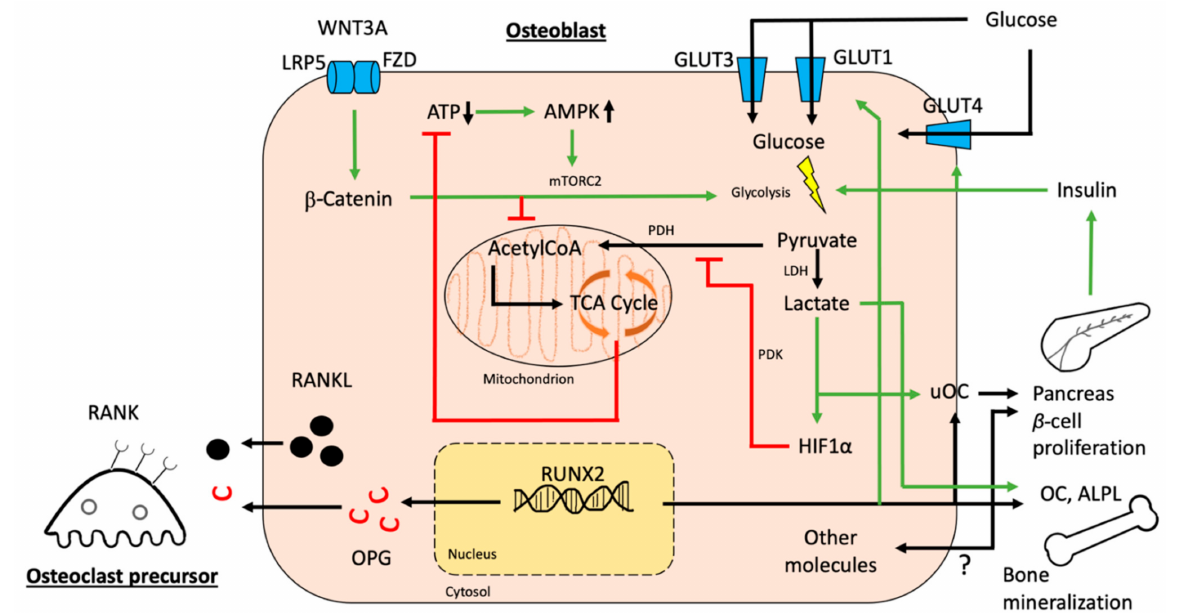
Figure 2. An overview of osteoblastic glucose pathways and secreted products. Intracellular energy metabolism relies on different feed-forward and negative feedback mechanisms. Abbreviations: LRP5 = low-density lipoprotein receptor-related protein 5; FZD = frizzled; GLUT1-4 = glucose transporters 1-4; ATP = adenosine triphosphate; AMPK = 5’ AMP-activated protein kinase; mTORC2 = mammalian target of rapamycin complex 2; TCA = tricarboxylic acid; (u)OC = (uncarboxylated) osteocalcin; HIF1 α = hypoxia induced factor 1alpha; ALPL = alkaline phosphatase; RUNX2 = runt-related transcription factor; OPG = osteoprotegerin; RANKL = receptor activator of nuclear factor kappa b ligand; RANK = receptor activator of nuclear factor kappa b; PDK = pyruvate dehydrogenase kinase; PDH = pyruvate dehydrogenase; LDH = lactate